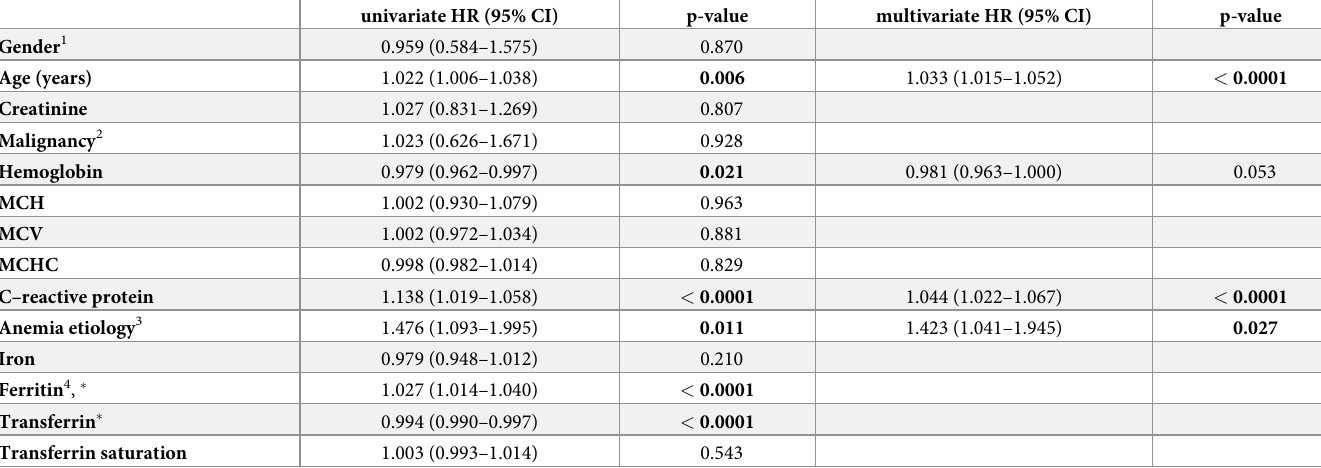
Table 3. Univariate and multivariate Cox regression on 1-year survival in patients with anemia and available serum iron